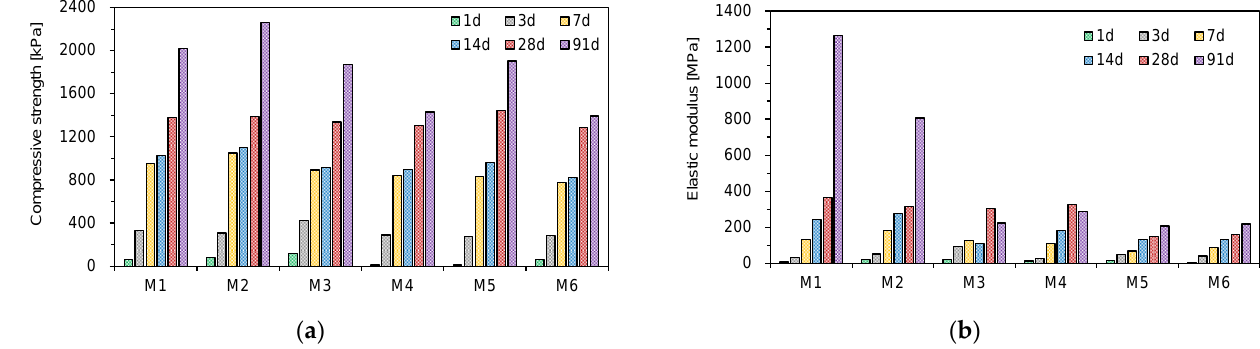
Figure 5. Results of unconfined compressive strength tests along curing time in different CLSM mixtures—( a ) unconfined compressive strength; ( b ) elastic modulus.